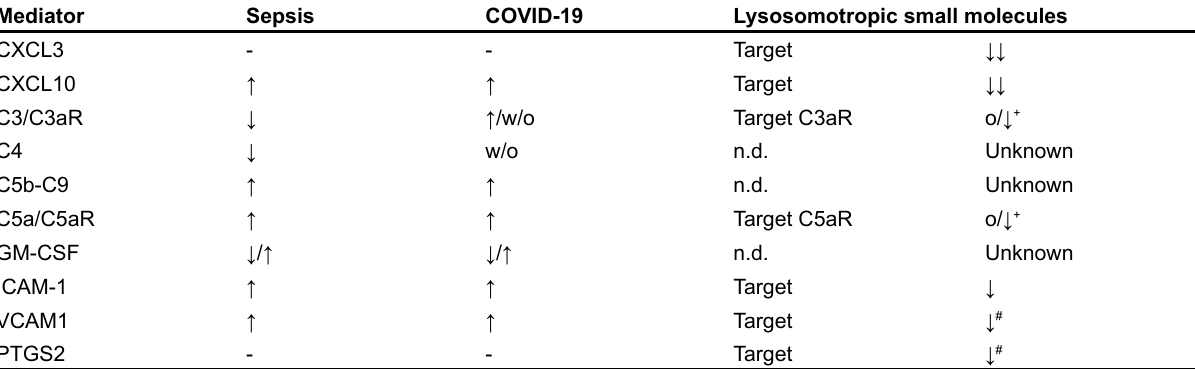
Table 1. Impact of small molecules on inflammatory messengers and growth factors in sepsis and severe SARS-CoV-2 infection/COVID-19 ( continued